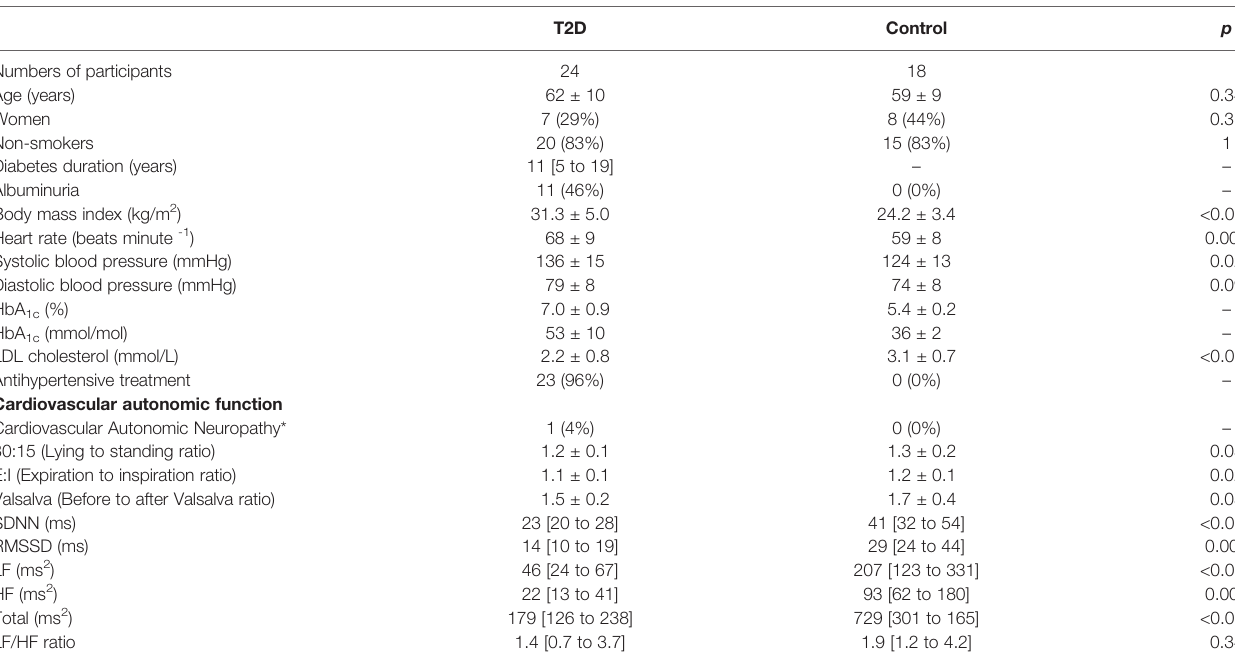
( Table 1 ). Baseline associations between cardiovascular autonomic function and measures of heart and kidney function are shown in Table S1 . A higher (more bene fi cial) 30:15 ratio was associated with a higher eGFR. Higher values of TABLE 1 | Baseline characteristics.